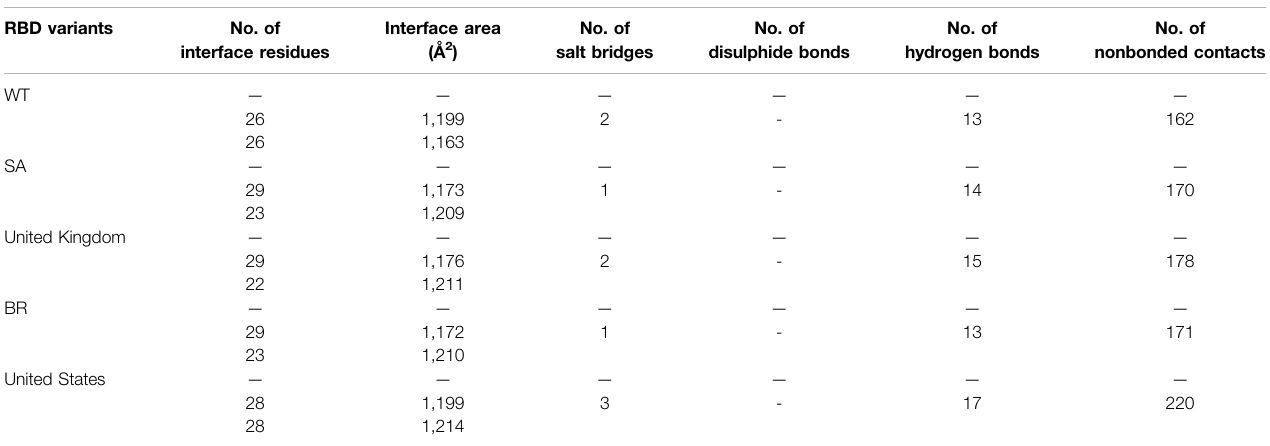
TABLE 3 | Interface residues, area, and the bonds between Bro and RBDs. RBD